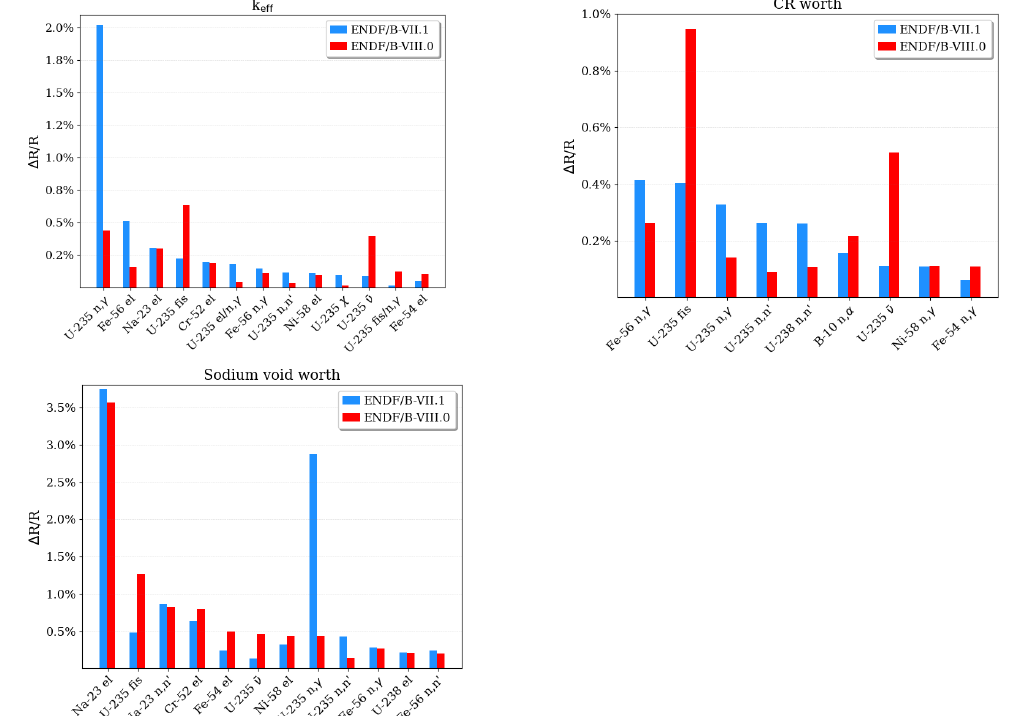
Figure 11. Contributions to the output uncertainties (as obtained with TSUNAMI-CE in ∆ R/R, R: response).